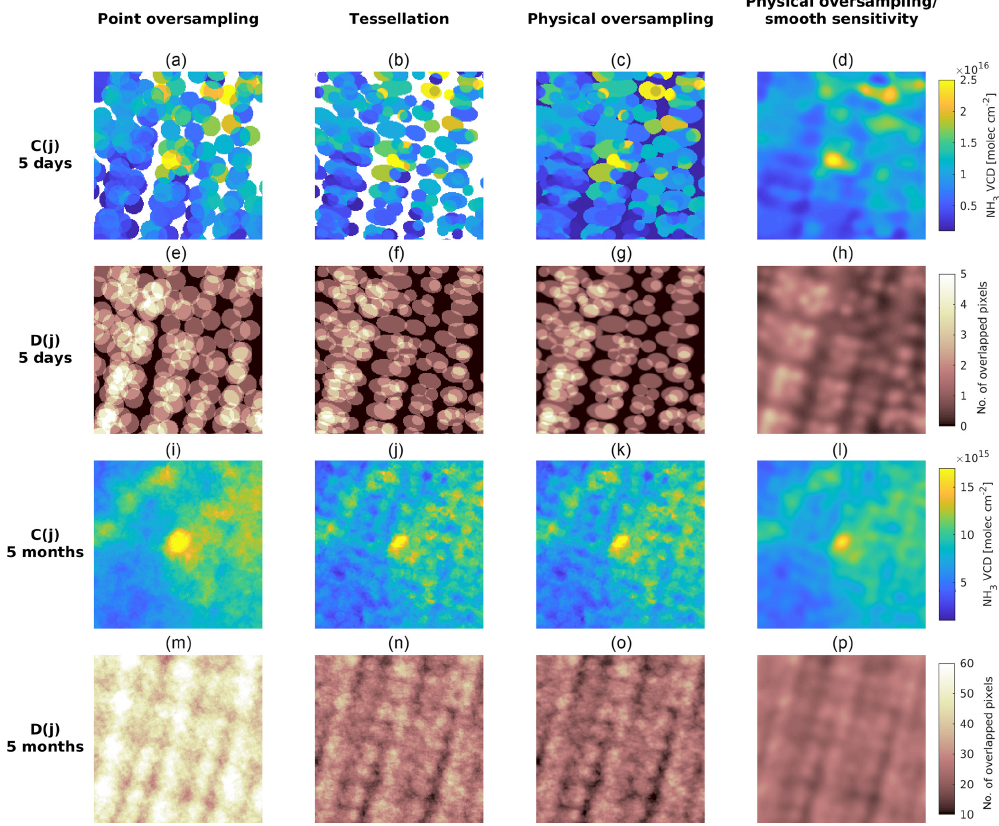
Figure 10. Similar to Fig. 9 using IASI NH 3 total column product for 2015. The drop-in-the-box approach is not included. Instead, the physical oversampling results using a smoother version of the IASI spatial response function are shown in panels (d, h, l, p) . The true IASI spatial response function has much sharper edges than OMI, such that the physical oversampling results (c, g, k, o) are very similar to tessellation results (b, f, j, n)